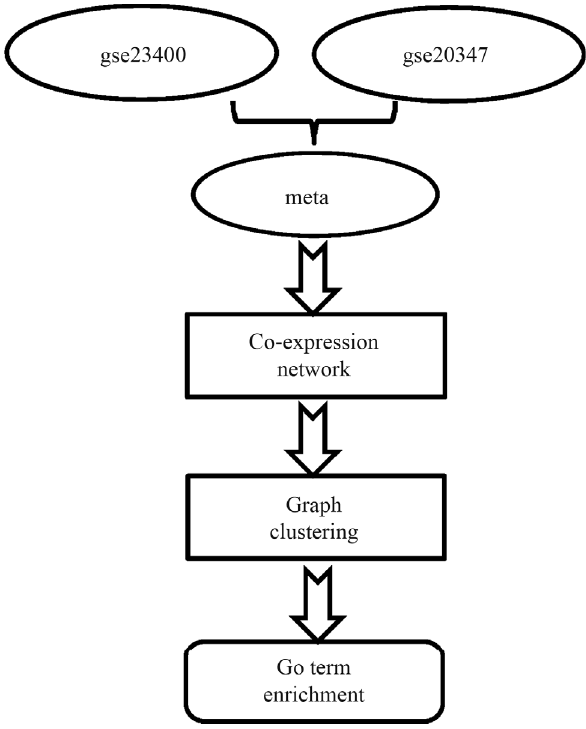
Figure 1 - Workflow of our study. The RankProd package was used for merging the GSE23400 and GSE20347 datasets, as was the Spearman Rank Correlation for constructing a co-expression network based on their expression profiles. The Graph-clustering approach was applied for iden- tifying enriched clusters. Finally, the function annotation of each cluster was found through GO-Term enrichment